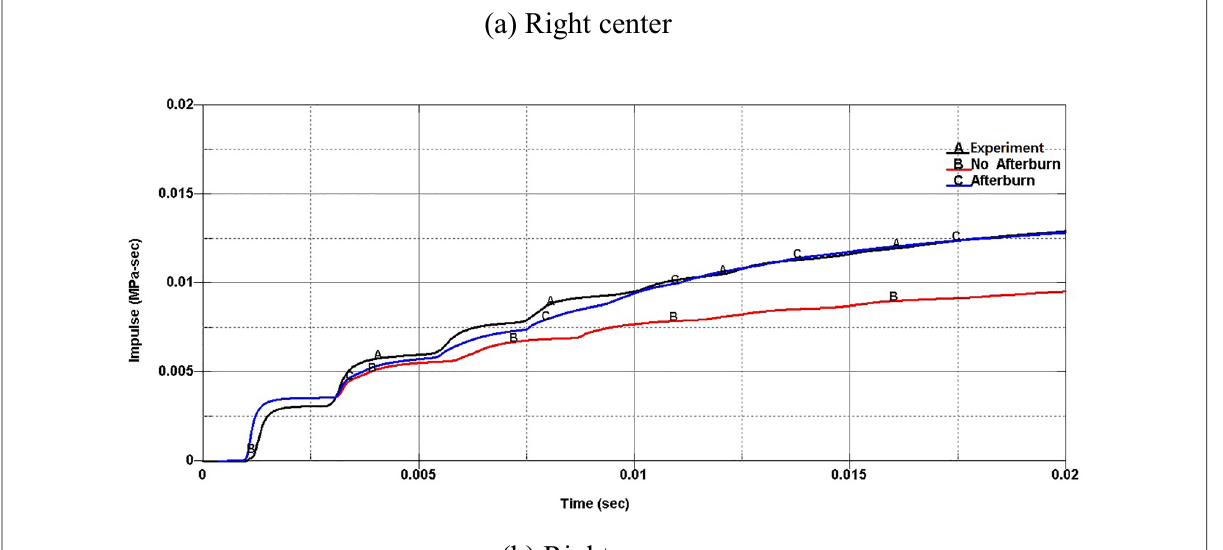
Fig. 27 Impulse comparison over time.